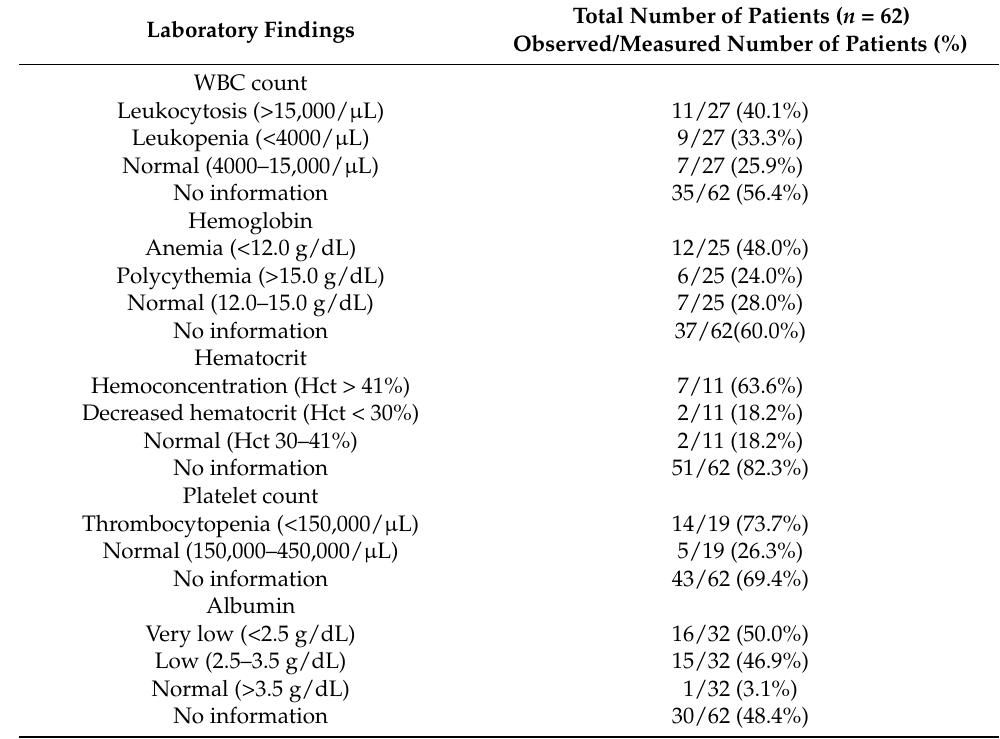
Table 4. Laboratory findings of cancer patients with systemic capillary leak syndrome.